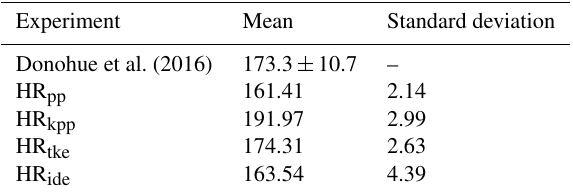
Table 3. Time-averaged volume transport (1Sv = 10 6 m 3 s − 1 ) of the Antarctic Circumpolar Current (ACC) through Drake Passage from observations and simulations with